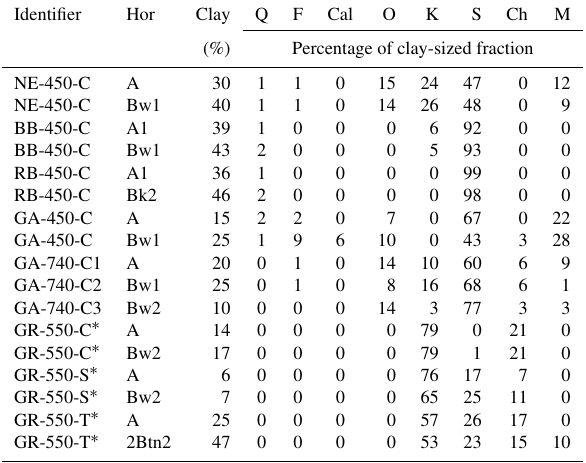
Table 2. Mineralogy determined on clay-sized XRD fraction for se- lected soils (mostly mafic soils that had higher clay contents). Ab- breviations are Hor, soil horizon, Q: quartz, F: feldspars, Cal: cal- cite, O: oxides, K: kaolins, S: smectites, Ch: chlorites, and M: mi- cas. Complete data can be found in Table